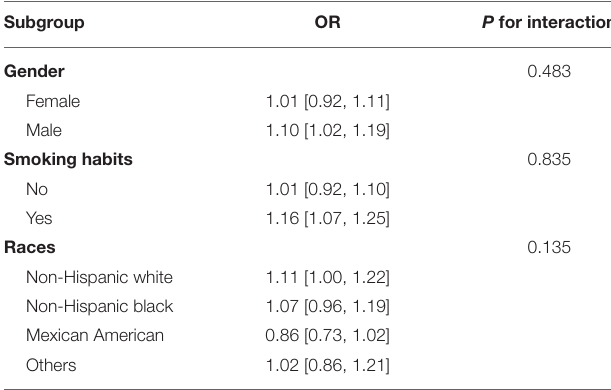
TABLE 3 | Two-piecewise regression analysis of the effect of thiocyanate on OP. TABLE 4 | Subgroup analysis of the effect of thiocyanate on